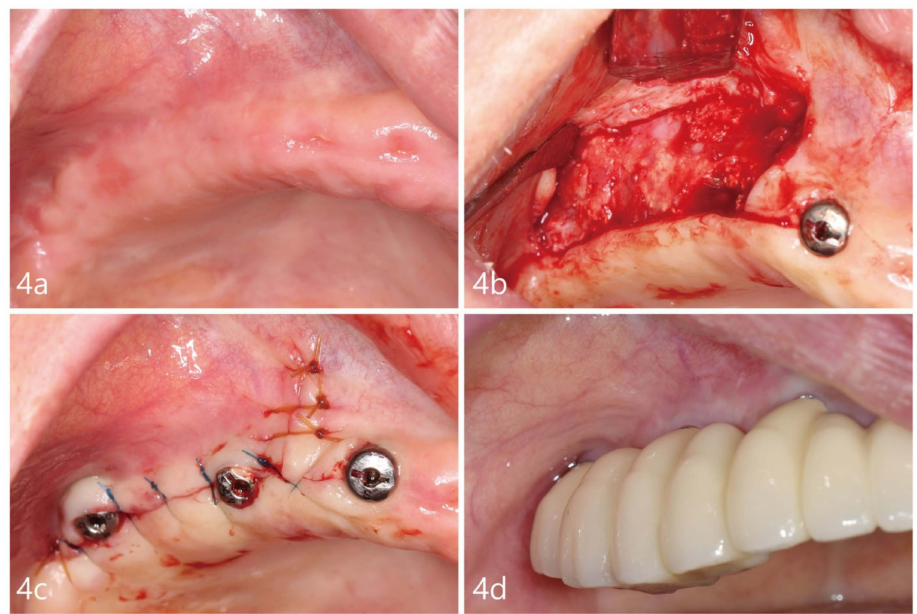
Figure 4. ( a ). Clinical photograph before uncovering of the fixtures. ( b ). New bone formation evident upon re-entry. A core was collected from an area away from the implants. ( c ). Placement of healing abutments and flap closures. ( d ). After 2 months of healing, a cementable final prosthesis was